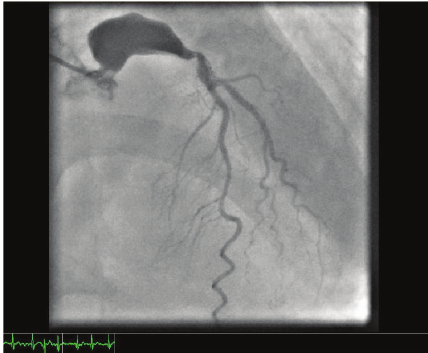
Figure 1: Coronary angiogram showing left main aneurysm (14 × 28) with obstructive leison at LAD ostial level.